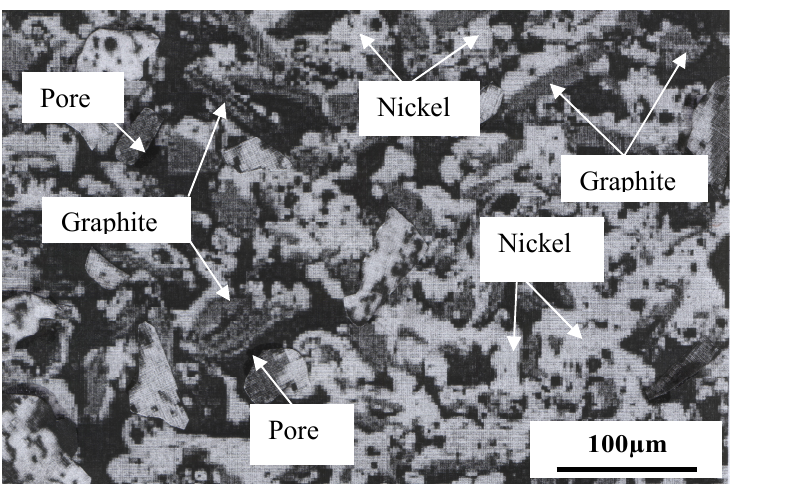
Figure 6 – Microstructure of Ni-25% graphite layers deposited with 700A